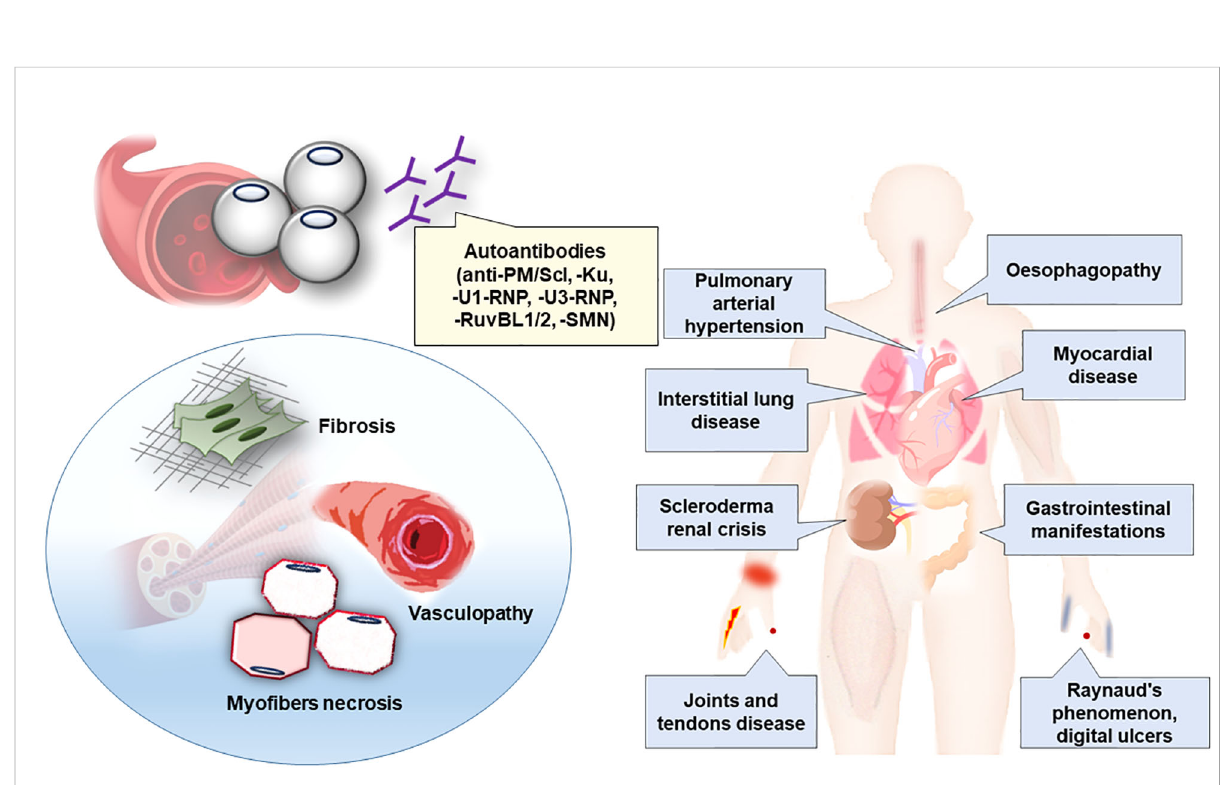
FIGURE 2 Clinico-sero-pathological de fi nition of scleromyositis. Clinical phenotype, autoantibodies and main histopathological lesions associated to scleromyositis have been